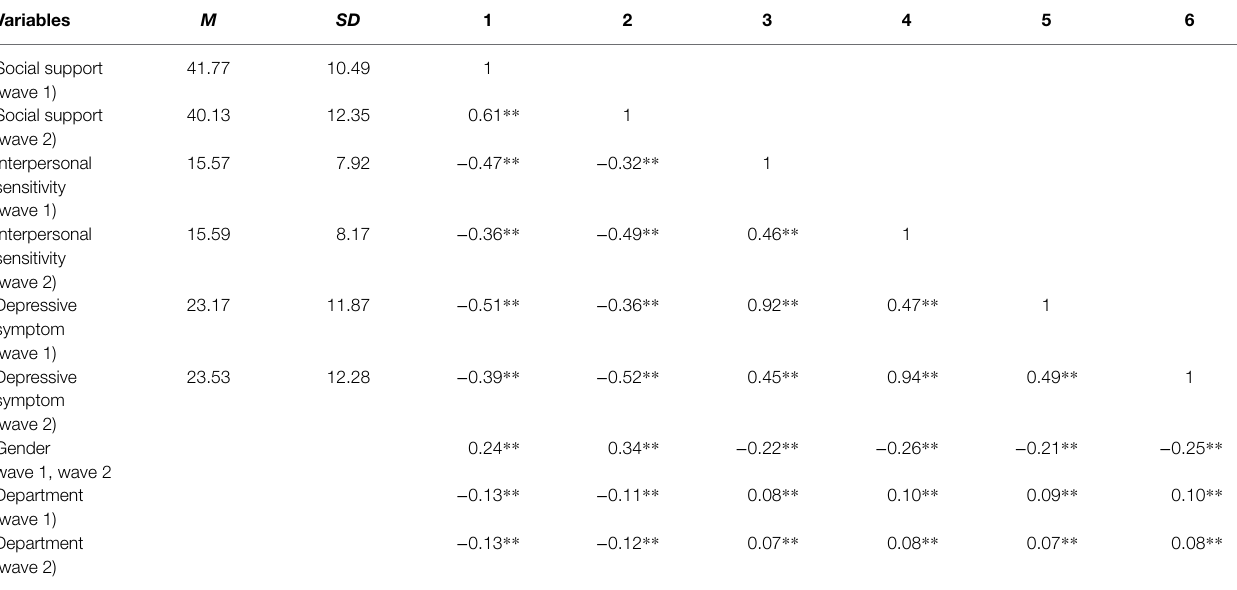
TABLE 2 | Bivariate correlations, means, and SDs of study variables.